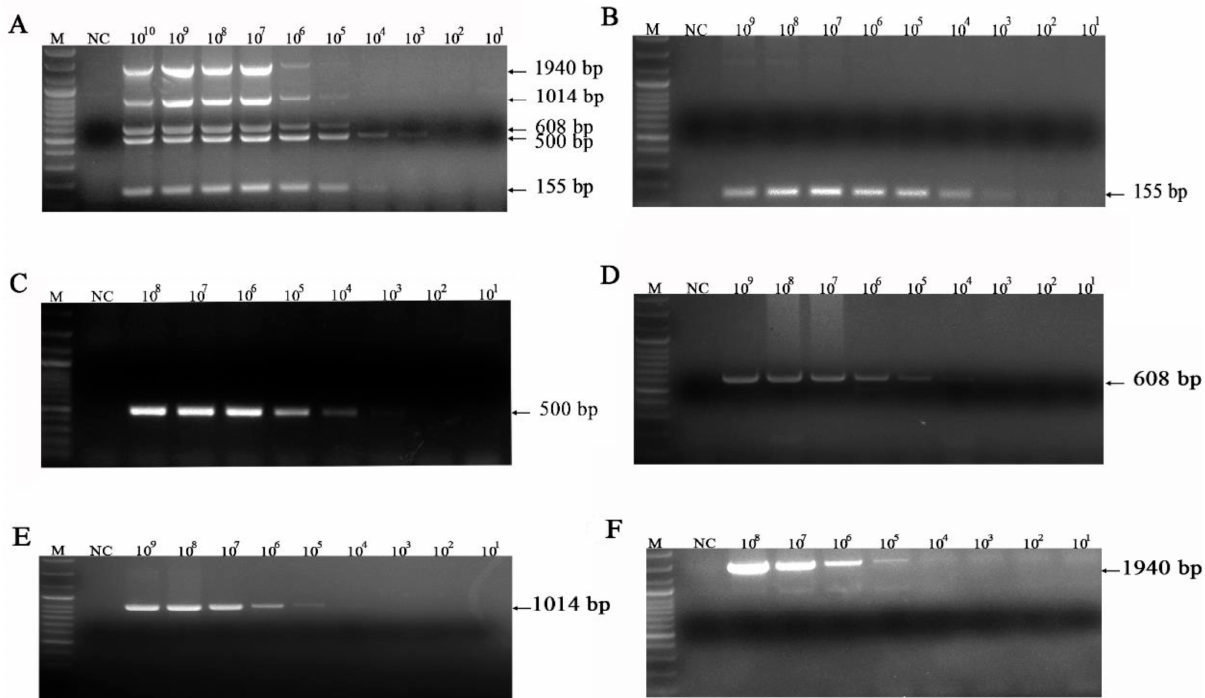
Figure 4. Sensitivity for FCV, FHV-1, FeLV, C. felis and IAV. ( B ) Sensitivity for IAV; ( C ) sensitivity for C. felis ; ( D ) sensitivity for FeLV; ( E ) sensitivity for FHV-1; ( F ) sensitivity for FCV; ( A ) sensitivity for IAV/ C.felis /FeLV/ FHV-1/FCV; lane M, DNA marker (100 bp ladder plus); lane NC, negative